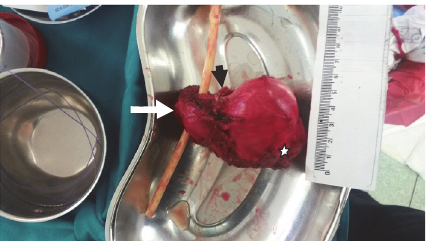
Figure 3: The surgical specimen. The prostate, 5 × 3.8 × 3.5 cm in size (arrow), the right seminal vesicle (arrowhead), and the tumor, 7 × 6.5 × 5.7 cm in size, which invaded the left prostatic lobe (white